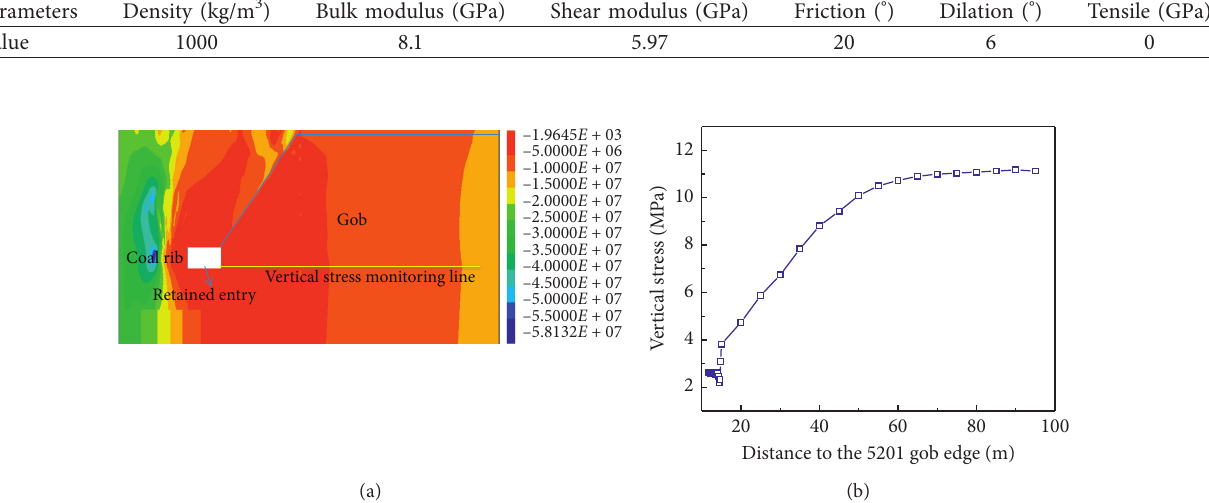
Figure 10: Vertical stress distribution of gob. (a) Vertical stress nephogram of gob. (b) Vertical stress